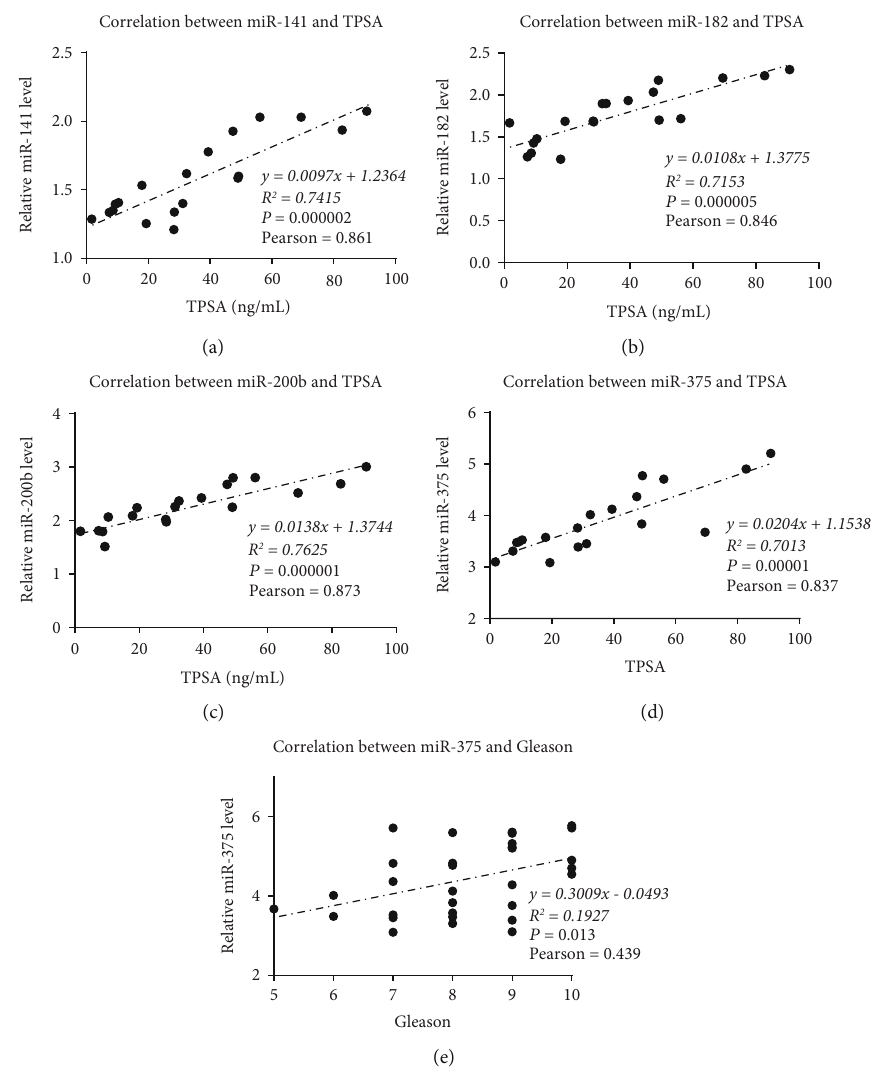
Figure 4: Correlations between the miRNAs and the TPSA level or Gleason score in the PCa subjects. (a) The correlation between miR-141 and TPSA, (b) the correlation between miR-182 and TPSA, (c) the correlation between miR-200b and TPSA, (d) the correlation between miR- 375 and TPSA, and (e) the correlation between miR-375 and the Gleason score. In our hospital, TPSA levels of higher than 100 ng/mL were marked as > 100 rather than an extract number; thus, the subjects with TPSA levels greater than 100ng/mL were excluded from the correlation analysis between the miRNAs and the TPSA